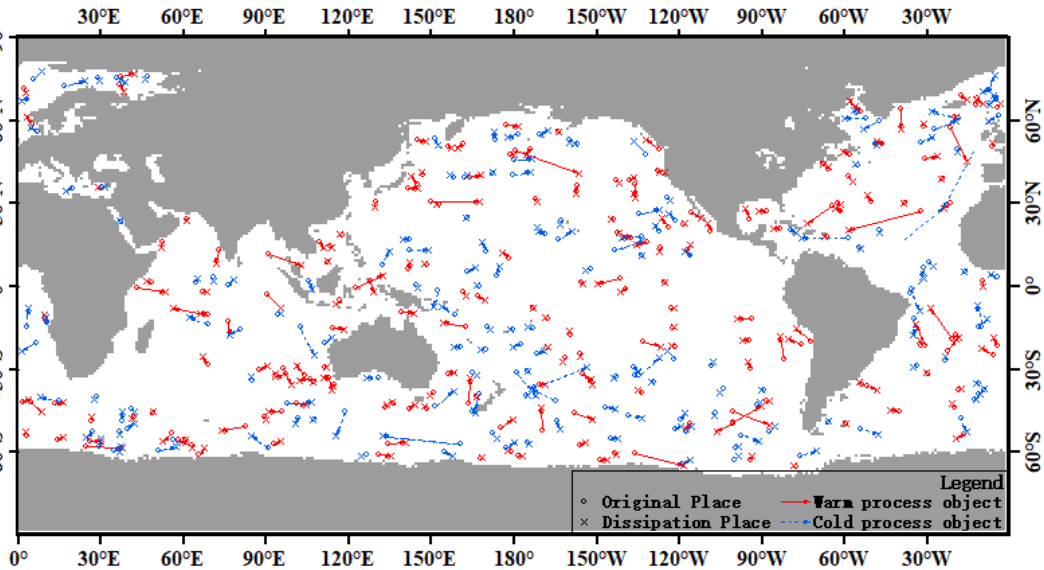
Figure 7. Spatial distribution of evolutionary structure Type I of SSTA dynamics. Red arrows represent moving directions of warm process objects of SSTA; blue arrows represent moving directions of cold process objects of SSTA.